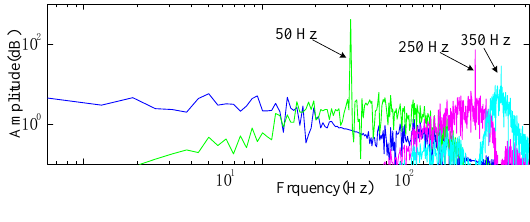
Figure 20. Performance of input signals with noise: ( a ) magnitude, ( b ) spectrum.